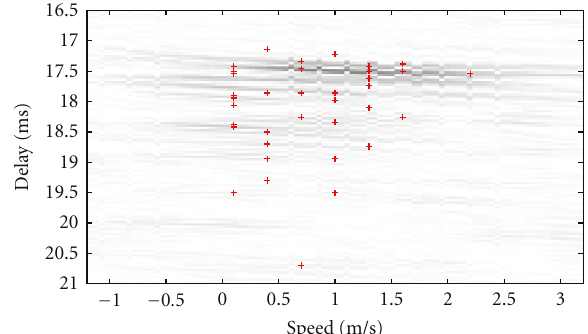
Figure 8: Zoomed-in version of Figure 7 around the first three arrival arrival groups in the wideband ambiguity function of the received LFM signal in the KAM08 experimental data. The crosses represent the maxima detected after each MPD iteration.